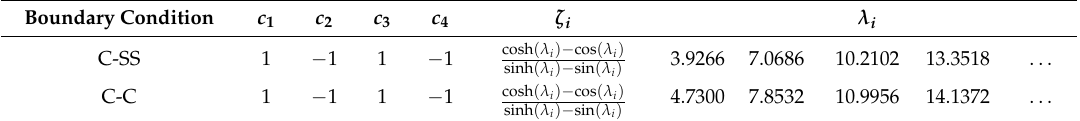
Table 1. Values of c 1 , c 2 , c 3 , c 4 , ζ i and λ i for different boundary